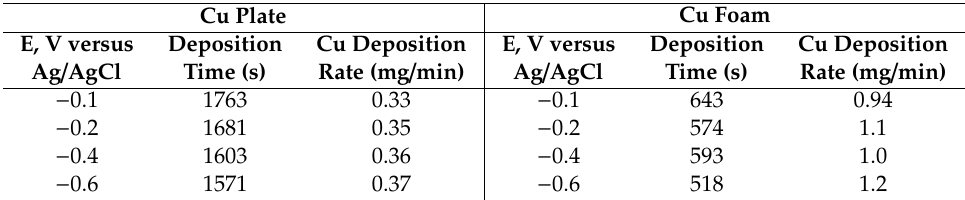
Figure 2. Cathodic voltammograms on Cu plate ( a ) and foam ( b ) obtained in the electrolytes with various concentrations of CuSO 4 (the compositions of solutions are shown in Table 1), potential scan rate 2 mV / s. Table 2. Cu deposition rates on 2D and 3D electrodes in the solution containing 0.1 M CuSO 4 and 0.4 M Na 2 SO 4 .